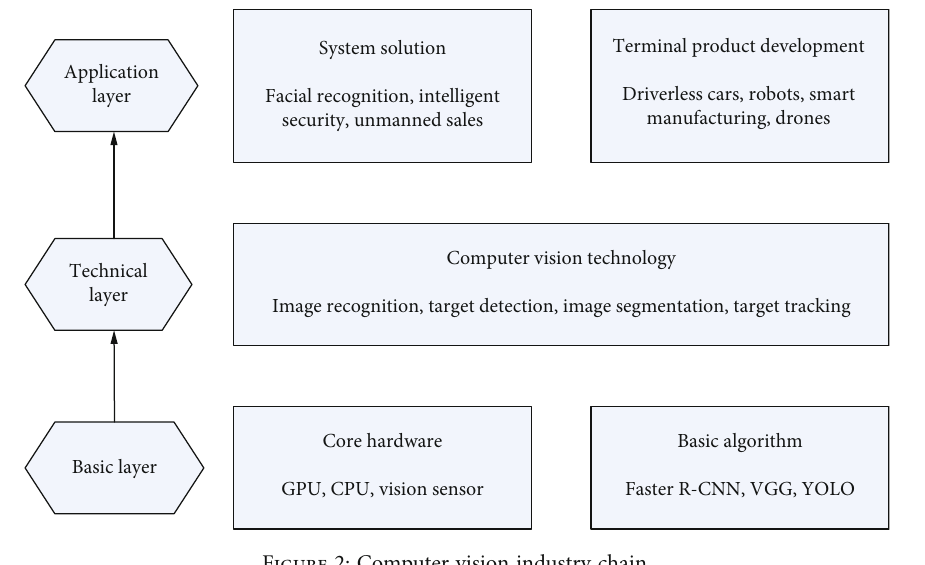
Figure 2: Computer vision industry chain.